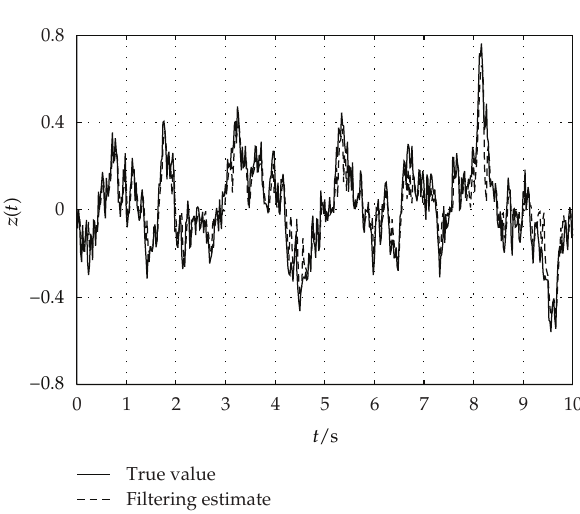
Figure 2: True value of signal z (cid:5) t (cid:6) (cid:5) solid line (cid:6) and its H ∞ filtering estimate (cid:5) dashed line (cid:6) .